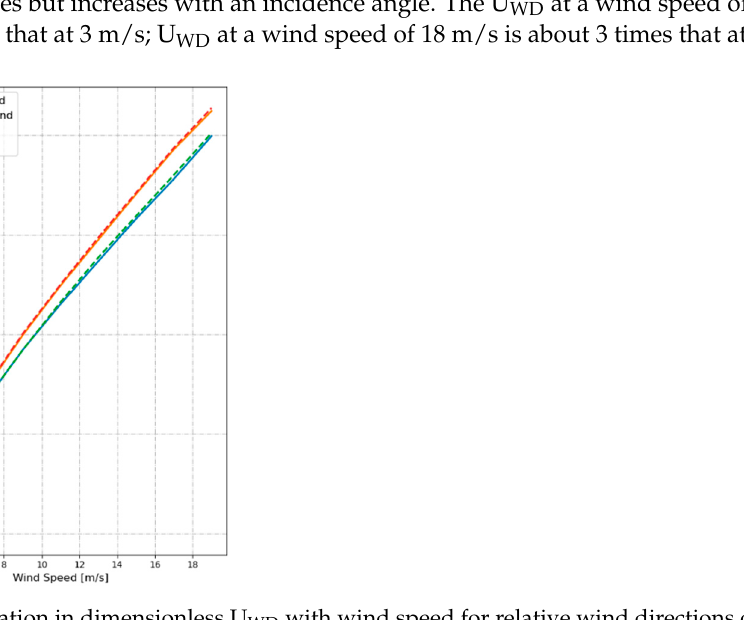
15 of 28 Figure 11. Variation in U WD and standard deviation with wind speed for radar incidence angles of 6° and 12°, azimuth angles of 0°, and 0°, 90°, and 180° wind directions without swell. The colored solid line indicates U WD , and the corresponding colored shading is the standard deviation. The asymmetry of downwind and upwind U WD at medium and high incident angles does not exist at small incident angles [19], which is mostly impacted by hydrodynamic modulation. The wind speed affects the position of the hydrodynamic modulation inten- sity on the long-modulated wave, and this impact diminishes as the wind speed decreases